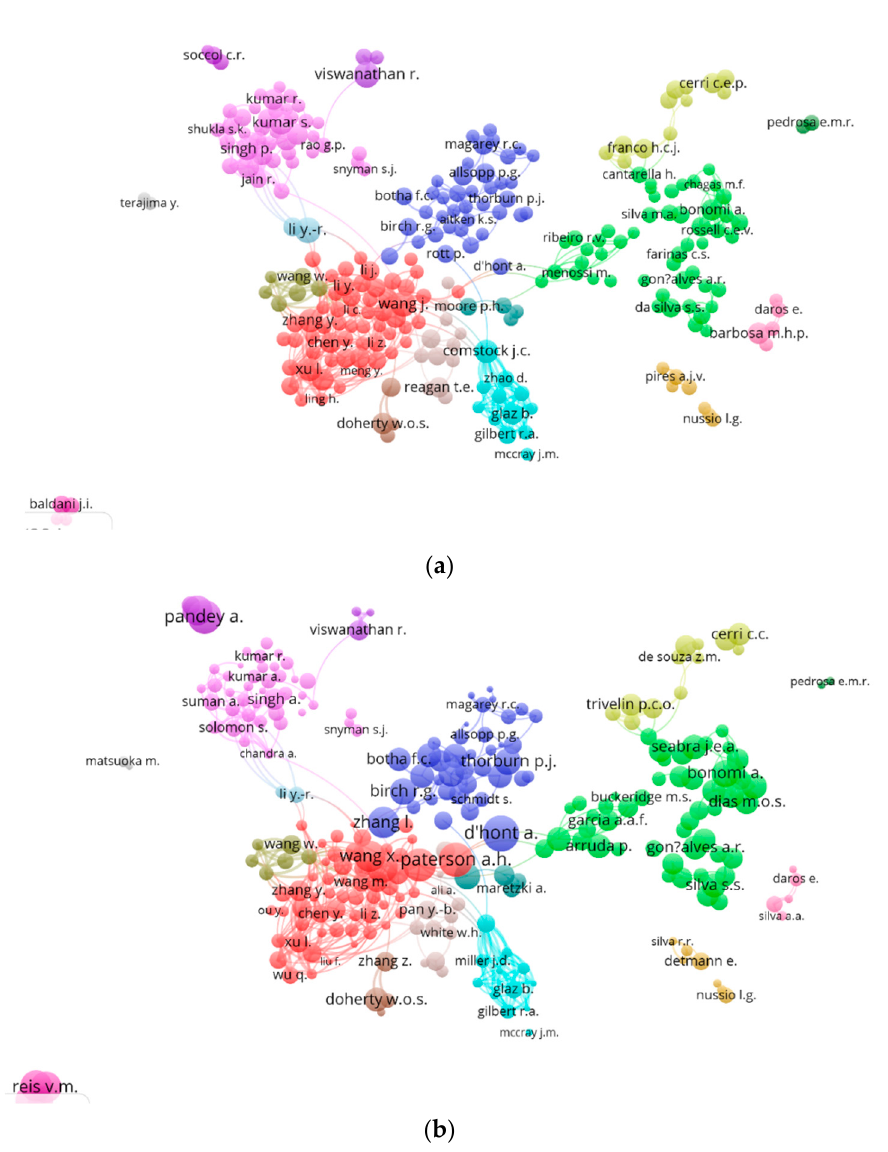
Figure 4. International co-authorship network of publications related to sugarcane research. ( a ) By number of documents. ( b ) By number of citations.